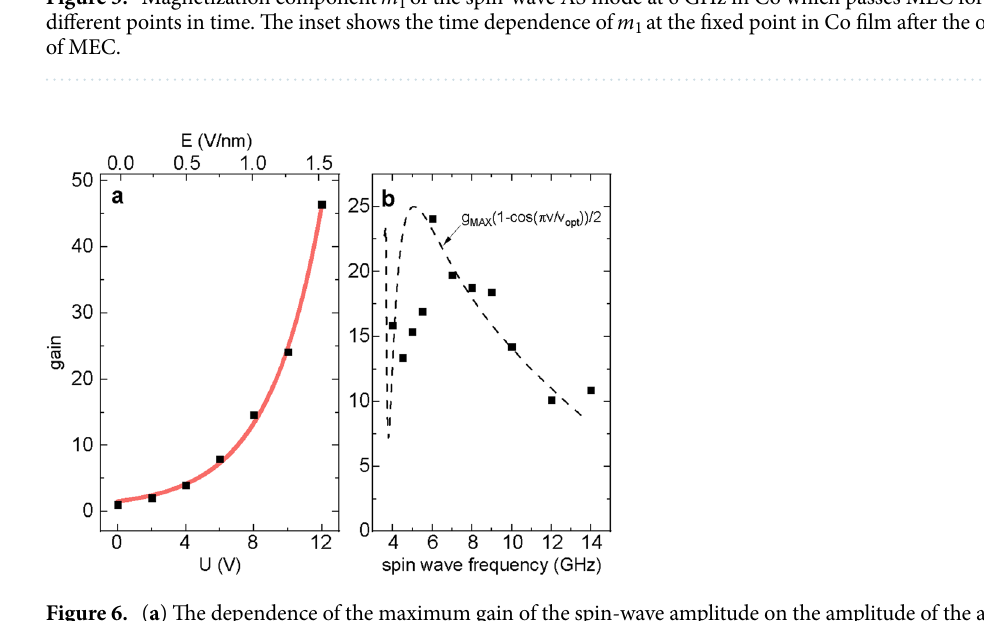
24 is the maximum gain obtained in Fig. 2. Here, v opt is the group velocity for the spin wave of 6 GHz and g MAX = simulations. Going from high frequencies, the gain reaches maximum at 6 GHz (for v opt ), suddenly drops at lower frequencies and increases again at the lowest frequencies. This is because the group velocity for the antisymmetric 0 . While the theoretical line fits well for higher frequencies, mode (see the red line in Fig. 2) increases for k ≈ some differencies are visible at lower frequencies, which is the result of the reflections at the MEC edges. Discussion